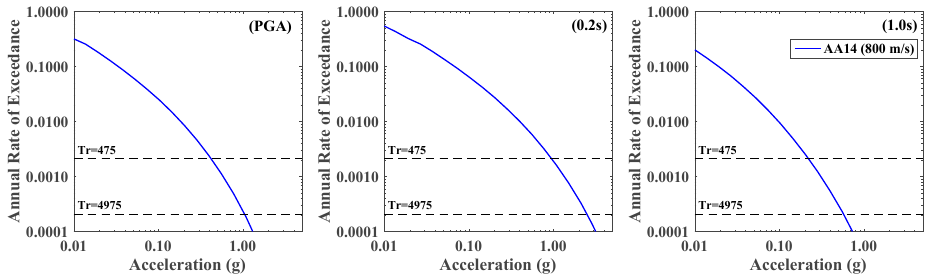
Figure 3. Target hazard curve on standard rock (V S30 = 800 m/s) at the Euroseistest calculated using Akkar et al., 2014 Ground Motion Prediction Equations (GMPE) (AA14) for three different spectral periods (PGA, 0.2 s, 1.0 s).